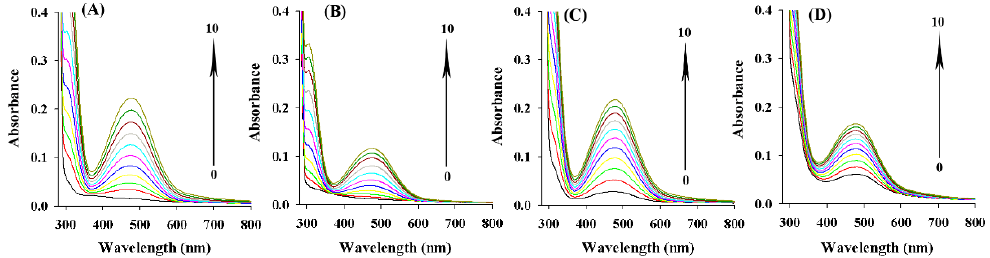
Figure 6. UV-vis spectra of the oxidation of L-tyrosine and L-DOPA by tyrosinase without ( A , C ) and with ( B , D ) ASBPs. Curves 0 – 10 represent 0 – 10 min after the addition of tyrosinase.